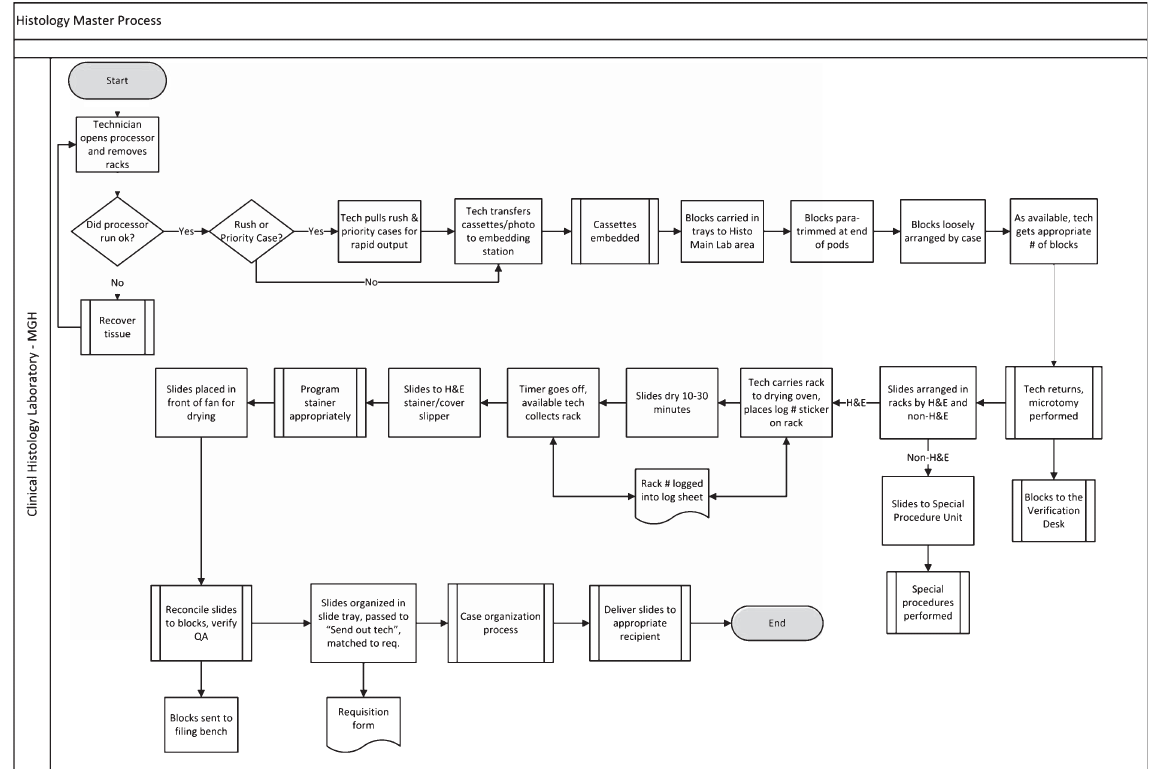
Fig. 1. Histology Master Process, Microsoft Visio Diagram, using BPMN